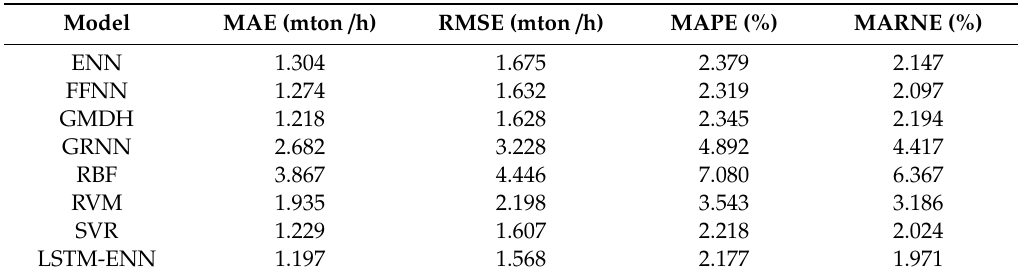
Table 10. Models comparison for Case Study